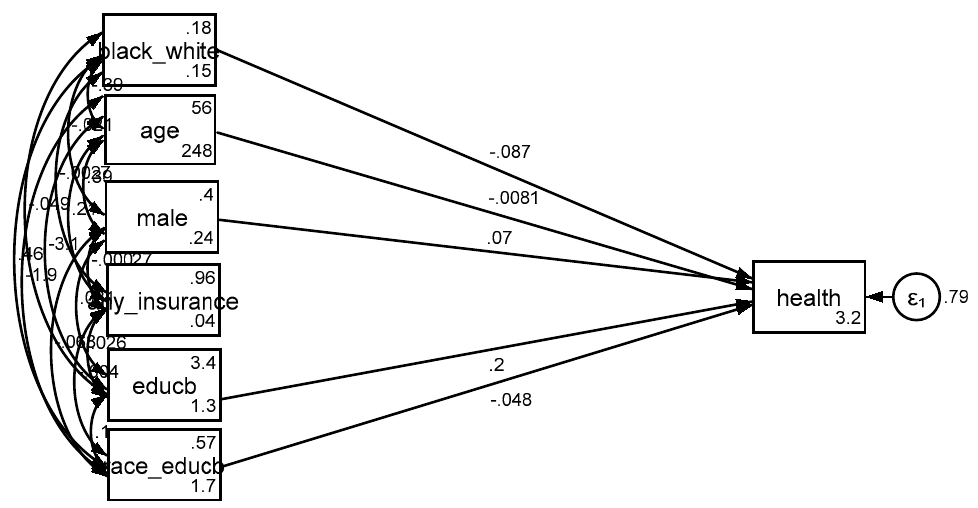
Figure 2. Summary of the results of Model 2 (interaction model without any mediator).